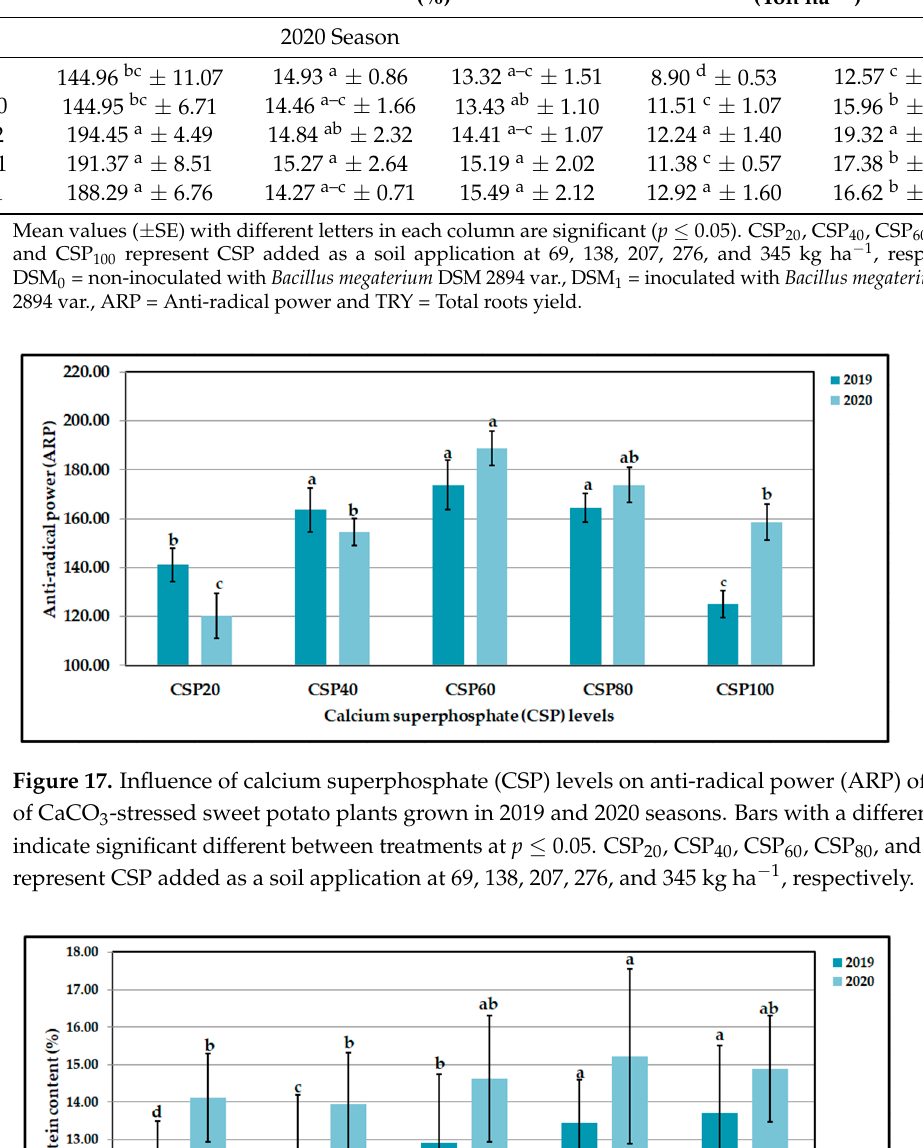
Figure 18. Influence of calcium superphosphate levels (CSP) on protein content of CaCO 3 ‐ stressed sweet potato plants grown in 2019 and 2020 seasons. Bars with a different letter indicate significant different between treatments at p ≤ 0.05. CSP 20 , CSP 40 , CSP 60 , CSP 80 , and CSP 100 represent CSP added as a soil application at 69, 138, 207, 276, and 345 kg ha − 1 , respectively.